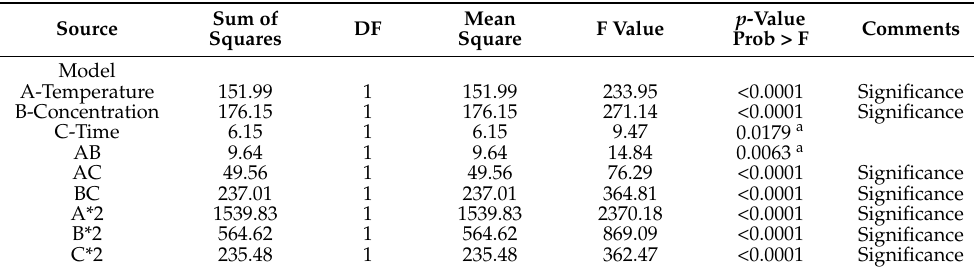
Table 2. The significance of all parameters in the regression models of glucose yield on ANOVA analysis.